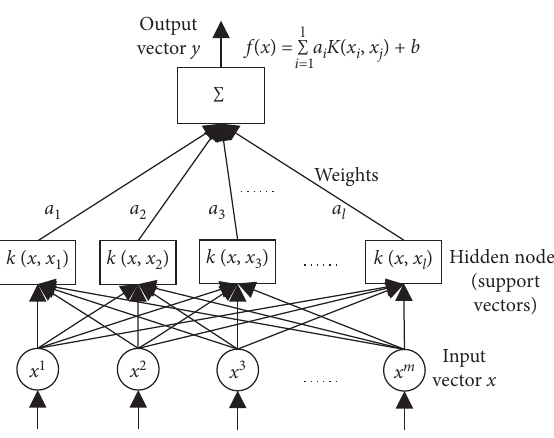
Figure 2: Support vector regression